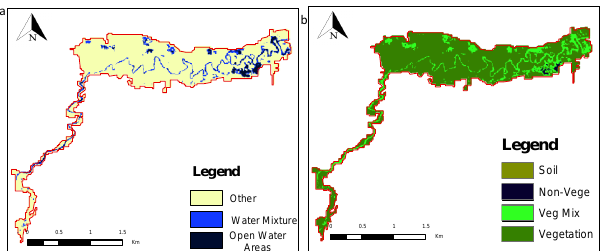
Figure 7. Object-based and index-based classification results